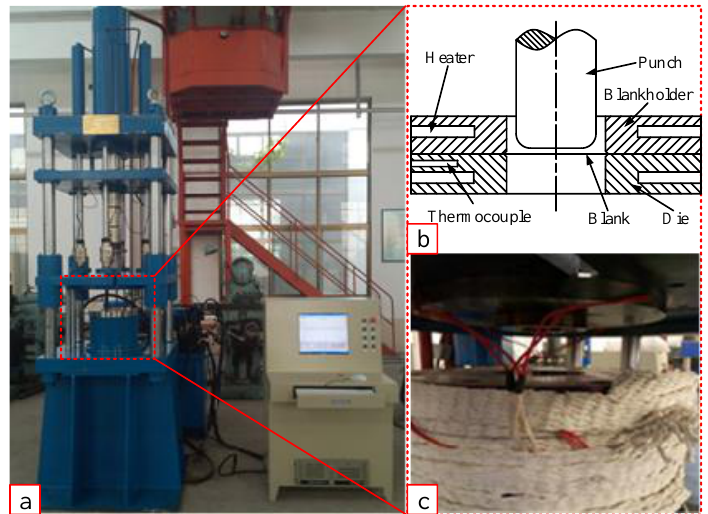
Figure 12. Equipment and die structures for hot stamping process of tube-shaped parts: ( a ) 100 T partitioned VBHF hydraulic machine, ( b ) die structure, ( c ) physical die.